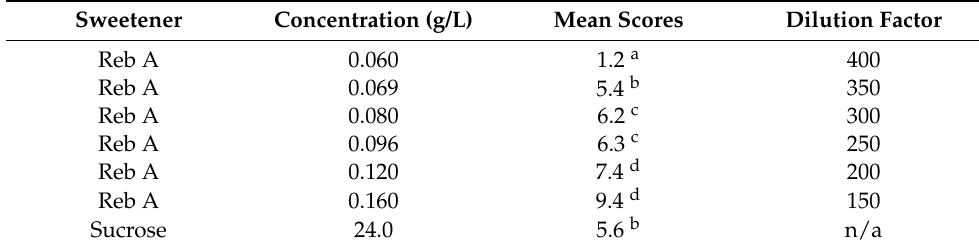
Table 3. Iso-sweetness of Rebaudioside A in aqueous solutions.